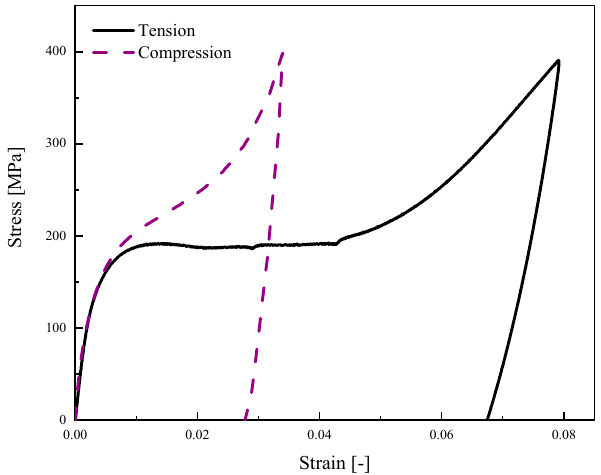
Figure 14. Monotonic tensile and compression tests for martensite SMA beam at room tempera- ture.